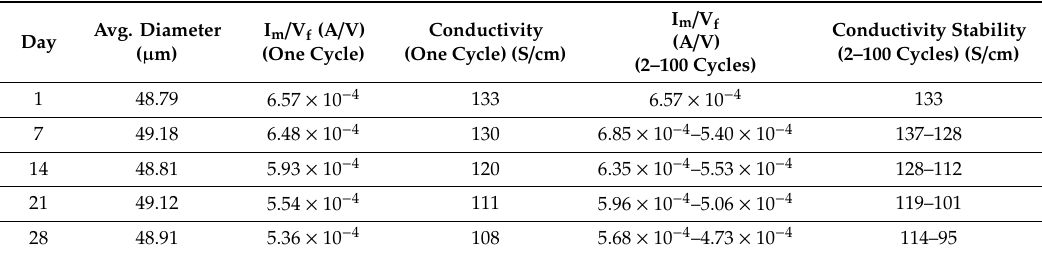
Figure 3. Conductivity and cyclic stability for the conducting PEDOT:PSS wires. ( a ) I–V curves obtained from fibers immersed in water over one month. The minor deviations show the high stability of the fibers. ( b ) Average value of conductivity over 100 cycles of testing. ( c ) Cyclic testing after one week of immersion. ( d ). Testing after four weeks of immersion. Table 2. Conductivity test for PEDOT:PSS fibers immersed in water for 1, 7, 14, 21, and 28 days (data reported here are for 3.8 cm fibers extruded using a 27 G needle). The average value from three different fibers is reported. The starting conductivity is 144 S/cm.